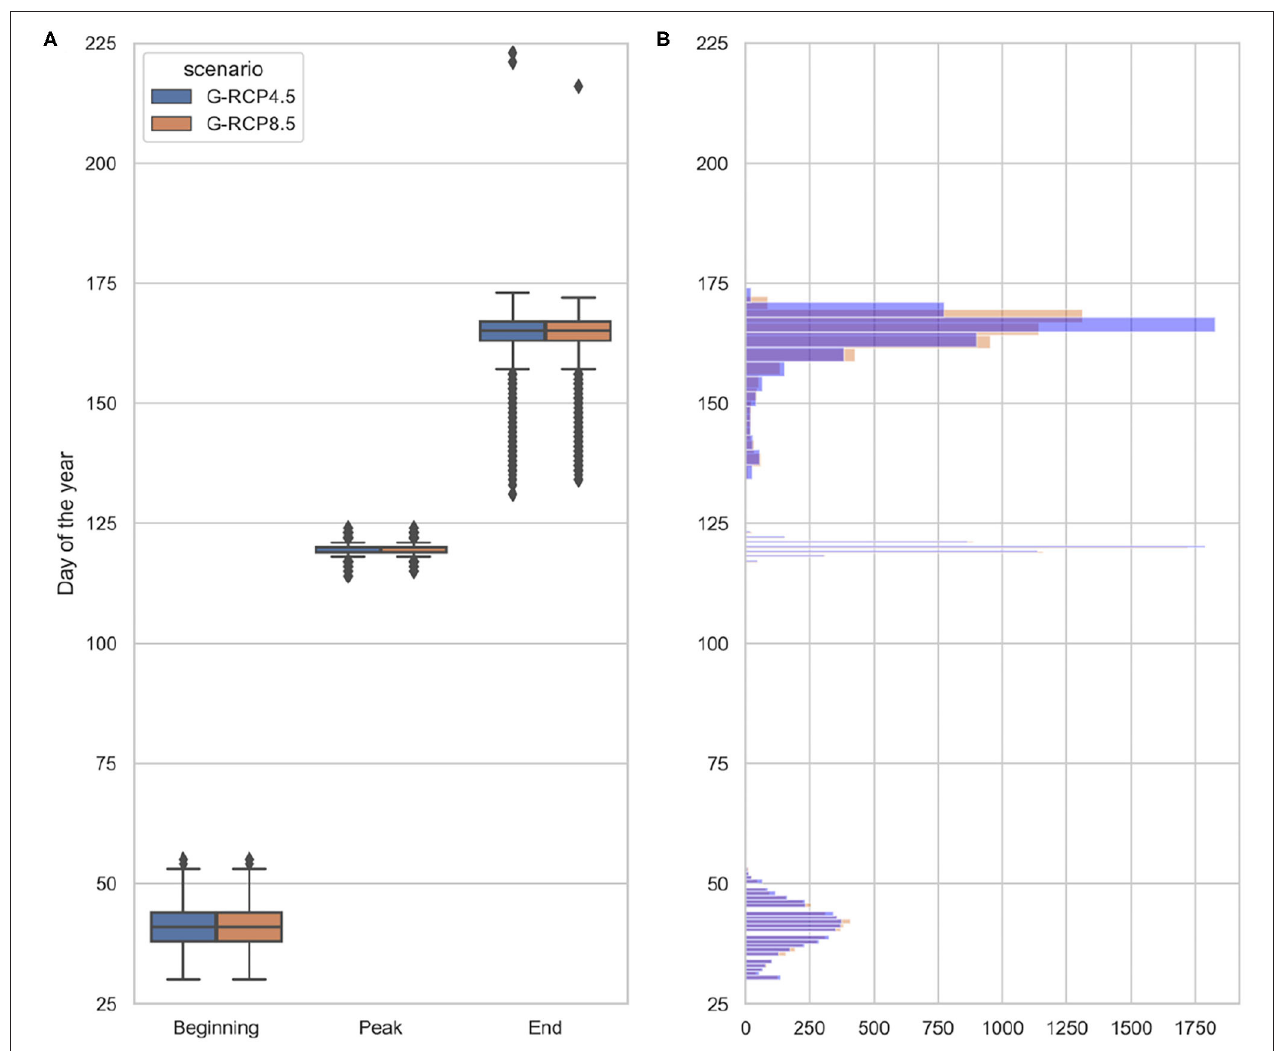
FIGURE 13 | Range of projected future bloom cardinal dates (A) and their distributions (B) under 120 generated radiation and temperature projections (based EURO-CORDEX) (2019–2089). The statistics are grouped based on the generated projections corresponding to RCP scenarios (G-RCP4.5 and